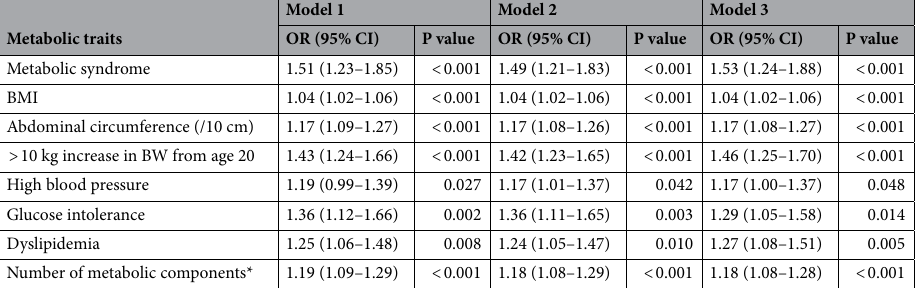
Table 4. Associations of metabolic traits and BW increase history with incident use of antidepressants. Model 1 was adjusted for regular exercise habits > 30 min a day, eating speed, late supper, skipping breakfast, poor sleep, and, drinking habits. Model 2 was adjusted for Model 1 plus hospitalization due to or associated with CVD, and cancer. Model 3 was adjusted for Model 2 plus use of hypnotics, anxiolytics, and NSAIDs. OR odds ratio, CI confidence interval, BMI body mass index, BW body weight. *The number of any of the following metabolic components: blood pressure, dyslipidemia, and glucose intolerance.